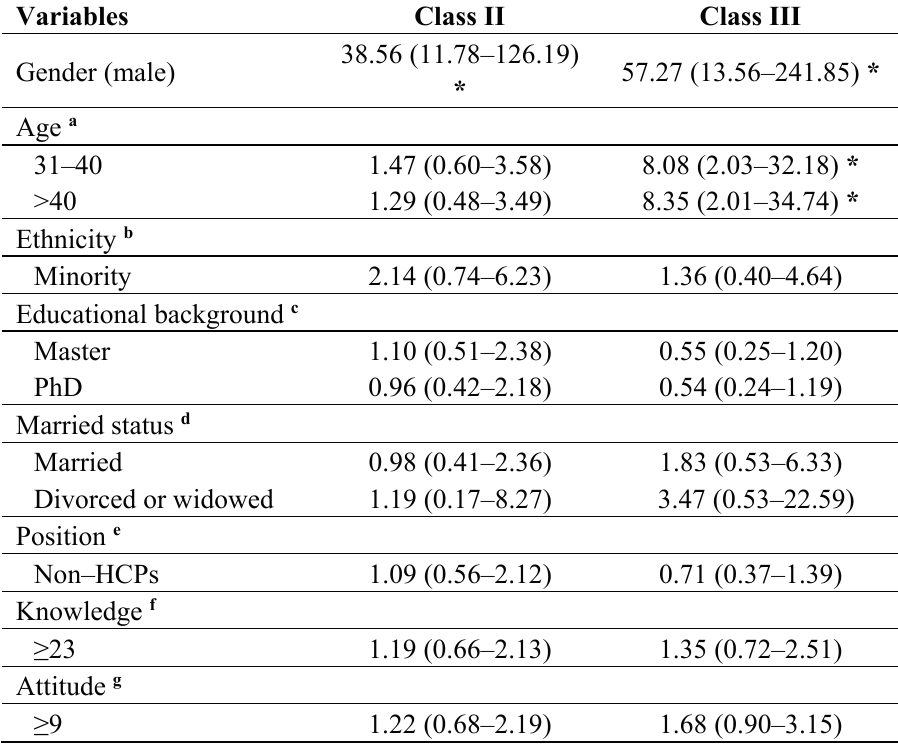
Table 3. Multinomial regression analysis